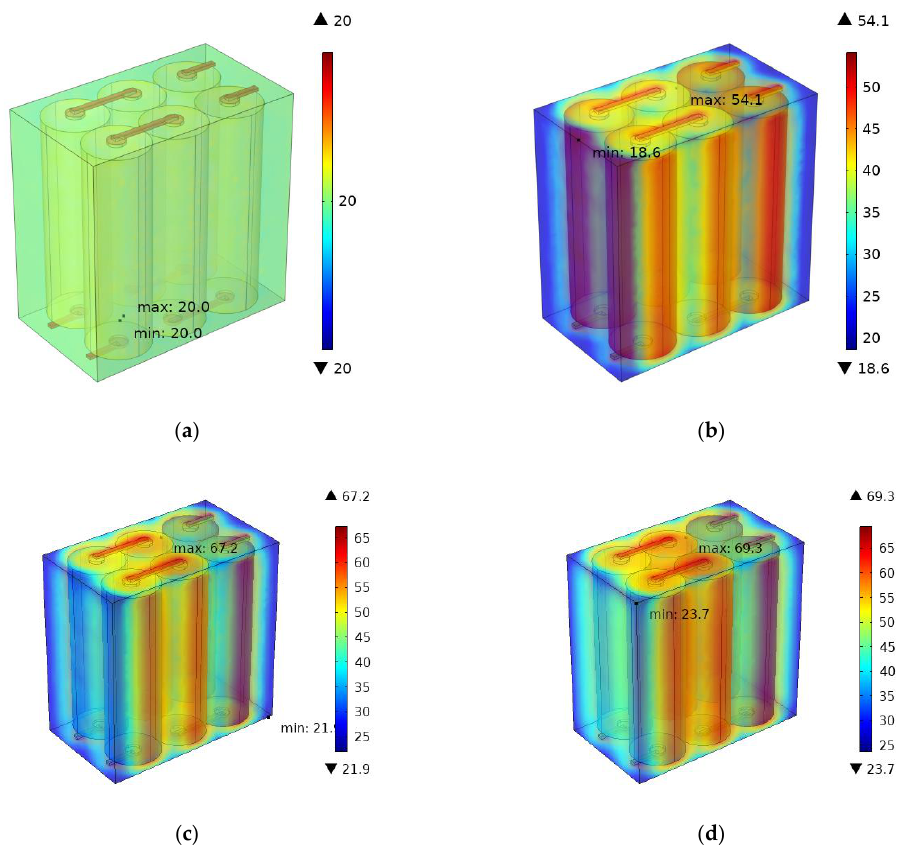
Figure 8. Temperature distribution inside the battery pack at different instants of time: ( a ) t = 0 s; ( b ) t = 500 s; ( c ) t = 1000 s and ( d ) t = 1500 s.